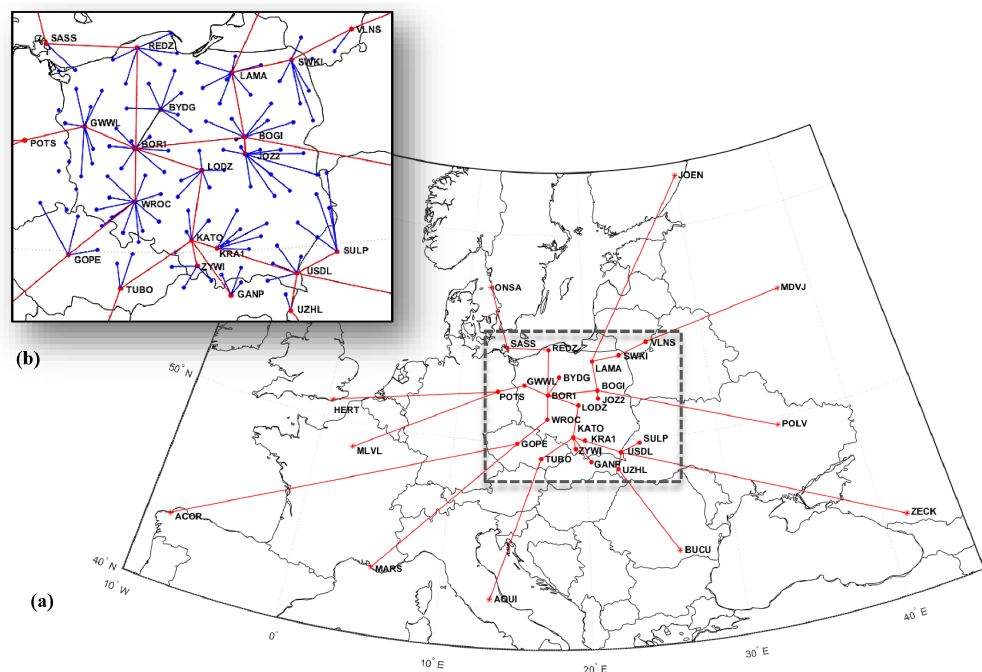
Figure 1. (a) Map of reference EPN stations used for processing, comprising 22 EPN stations in Poland and near countries and 11 remote stations. (b) Zoom of ASG-EUPOS stations (blue dots) and EPN reference stations (red dots). The ASG-EUPOS stations are connected to the nearest EPN station in the star network in Poland (blue